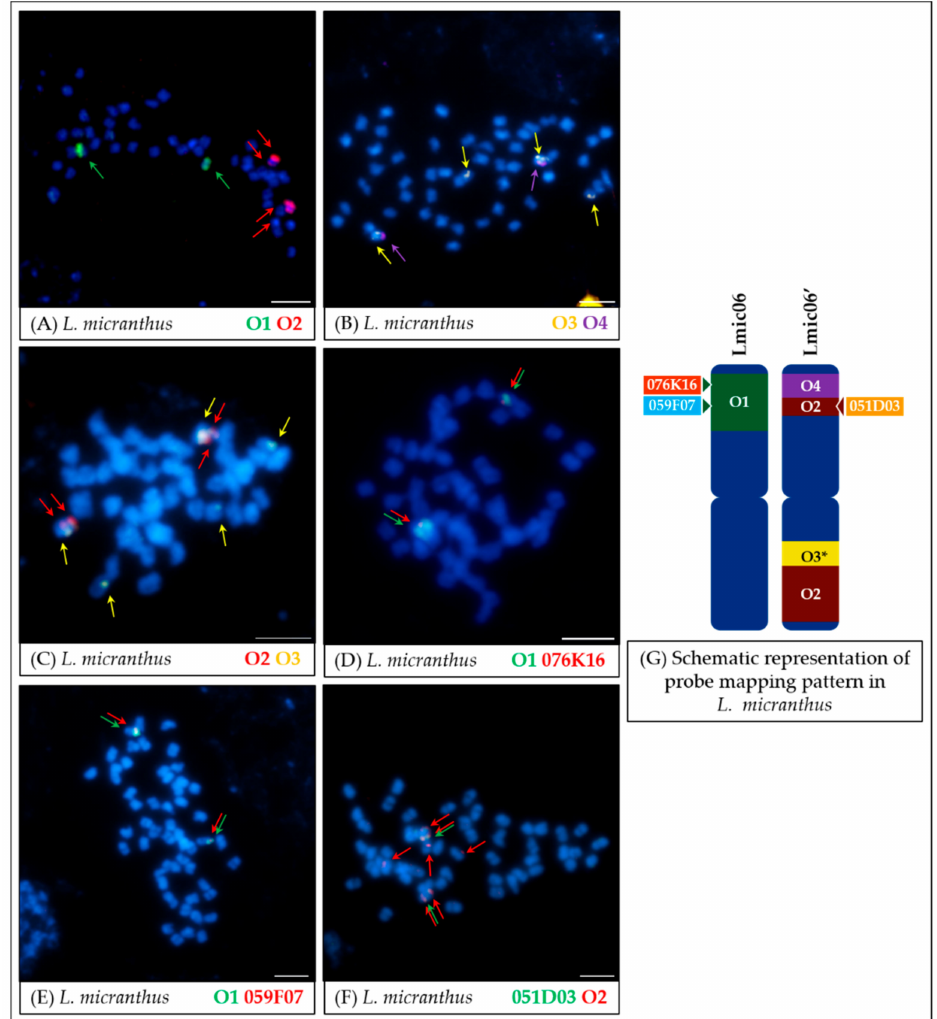
Figure 5. FISH mapping of oligonucleotide probes ( A – C ) and oligonucleotide probes combined with BAC clones ( D – F ) on mitotic chromosomes of L. micranthus . The positions of individual probes are marked by arrows. Probe colors are as follows: green (O1, Lang06 arm A), red (O2, Lang06 arm B), yellow (O3, pericentromeric region of Lang06 arm B), and purple (O4, telomere region of Lang06 arm B). Scale bar: 5 µ m. Schematic representation of probe mapping pattern in L. micranthus chromosomes ( G ), showing observed positions of particular oligonucleotide-based or BAC-based probes, was not drawn to scale. O3*—beside two major loci, minor signals were also